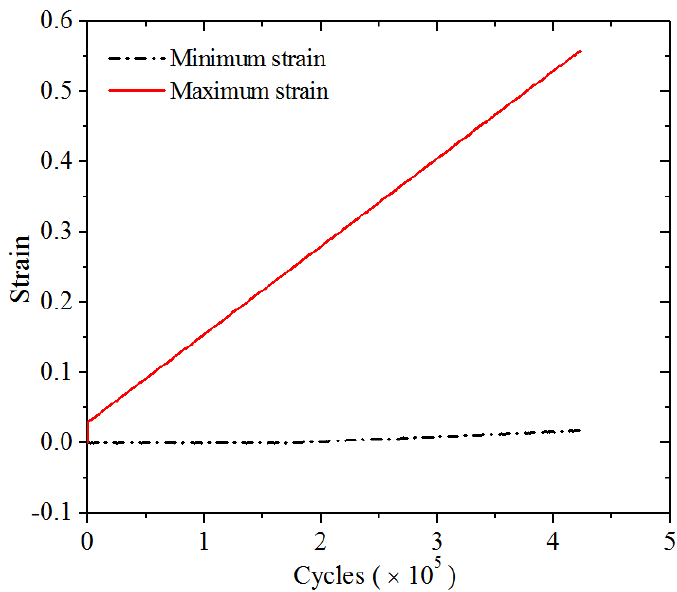
Figure 8. The imposed variable amplitude loading in the strain-controlled experiments.